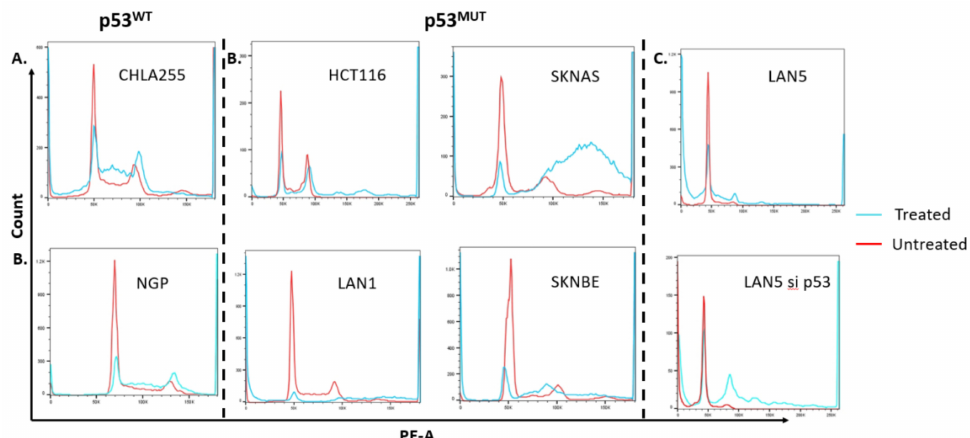
Figure 3. Cell cycle arrest as demonstrated by PI staining in neuroblastoma cell lines after treatment with pevonedistat. ( A ) Cell cycle arrest in p53 WT neuroblastoma cell lines that were untreated (red line) or after treatment with pevonedistat at Ic50 as noted in Figure 1 (blue line): G0/G1 arrest in p53 WT CHLA255 and NGP neuroblastoma cells. ( B ) Increased copy number accumulation in p53 MUT cell lines including colon cancer cell line HCT116 and the neuroblastoma cell lines SKNBE, LAN1 and SKNAS. ( C ) Cell cycle arrest in LAN5 and accumulation of high copy number cells in LAN5 p53 knockdown cell lines. Sub G1 fraction in LAN5 treated likely apoptosis as demonstrated in Figure 3B.